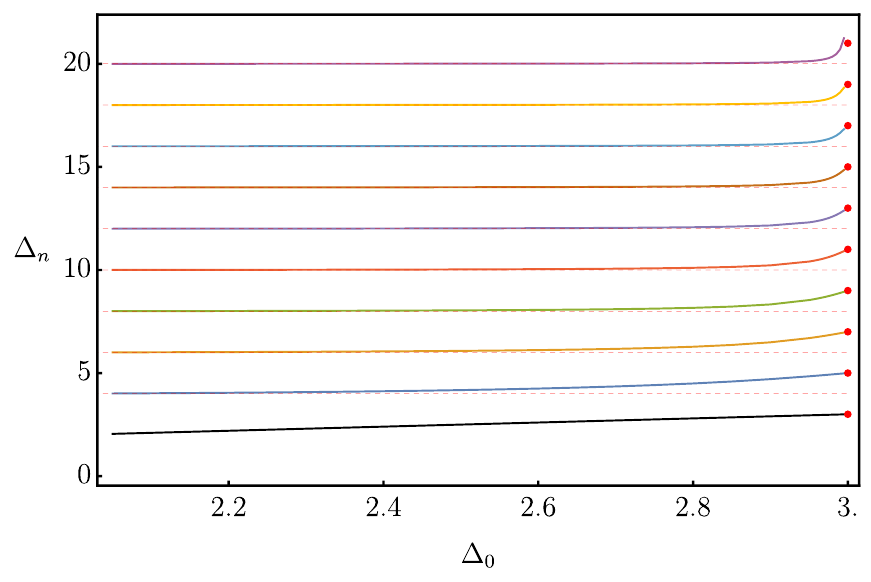
Figure 6 . Extremal spectrum as a function of the lowest dimension operator with N = 19 com- ponents. The dashed lines represent the generalized free boson spectrum, while the red dots stand for the free fermion